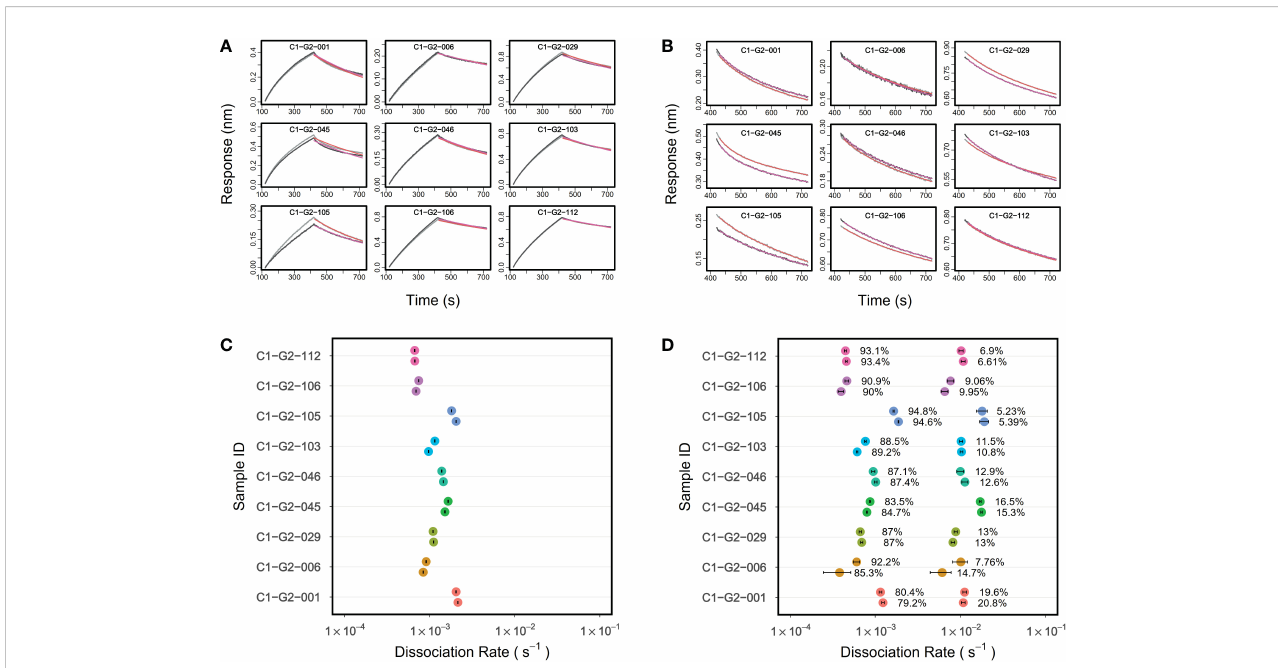
FIGURE 5 PAART analysis dissects two dissociation rates from malaria vaccinees ’ serum IgG antibodies-NPNA3 interaction. (A) Association and dissociation time- courses in duplicate (grey and black lines) of serum IgG antibodies (at 50 µg/ml concentration) of vaccinees from a Phase 2a malaria vaccine trial interacting with NPNA3 peptide are shown along with the overlaid fi ts (red lines) obtained using Langmuir dissociation. The vaccinees received three doses of RTS,S/AS01 vaccine at months 0,1 and 2. IgG antibodies were puri fi ed from the post third immunization sera a day before the Pf sporozoite challenge. (C) The dissociation rates (in duplicate) estimated using standard Langmuir dissociation fi t are displayed for different vaccinees (B) Dissociation time-courses of vaccinees shown in panel A with overlaid best fi ts from PAART analysis are shown. (D) PAART analysis derived dissociation rates (in duplicate) and their fractions of different vaccinees are displayed. In panels (C, D) , the error bars associated with symbols indicate the standard error in the estimate of k d